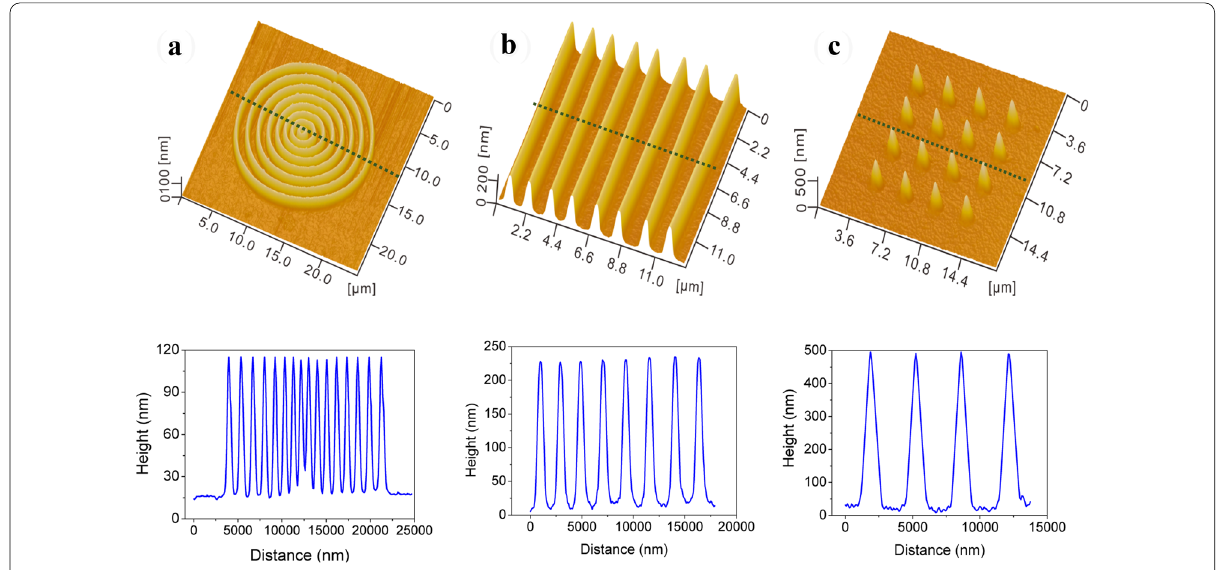
Figure 24 UV/ozone-assisted fabrication of optical structures on GaAs surface [87]: ( a ) circular grating, ( b ) diffraction grating, and ( c ) pyramid-shaped array (All profiles at the bottom were obtained from the corresponding dotted lines on the upper AFM